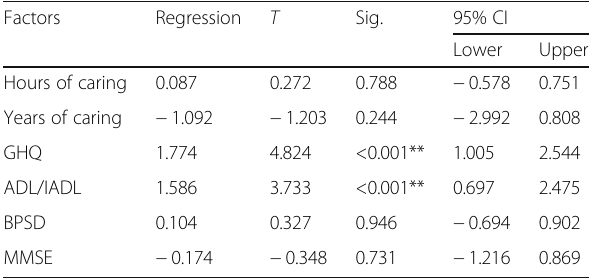
Table 6 Predictors of caregiver ’ s burden